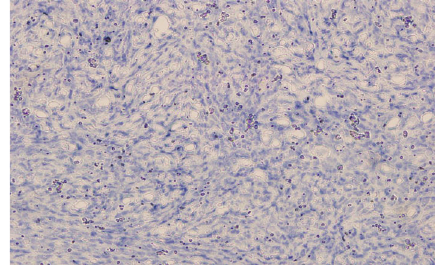
Figure 4: Immunostaining was negative for